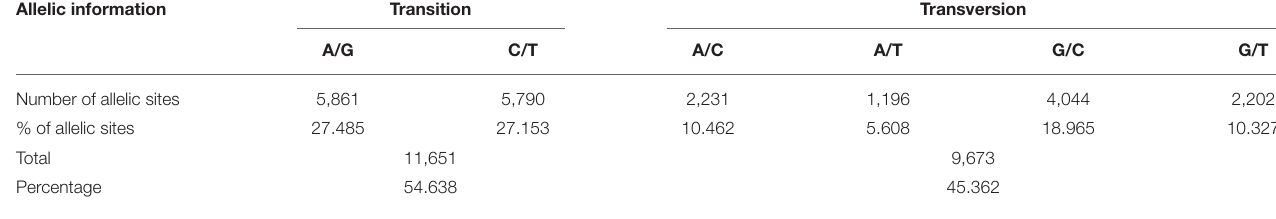
TABLE 2 | Proportion of transition and transversion SNPs discovered.